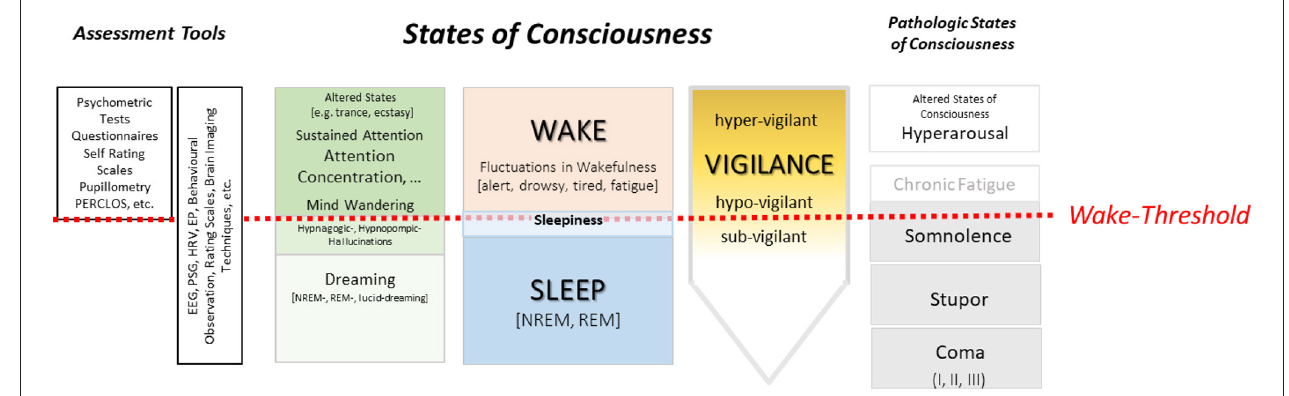
FIGURE 1 | Overview of the different concepts and terminologies related to vigilance and states of consciousness (as well as pathologic states). In the graph also some wiedly used assessment tools are listed. For example, methods such electroencephalography (EEG), polysomnography (PSG), heart rate variability (HRV) or evoked potentials (EP) can be used for sleep and wake, whereas psychometric test or questionnaires are usable only in